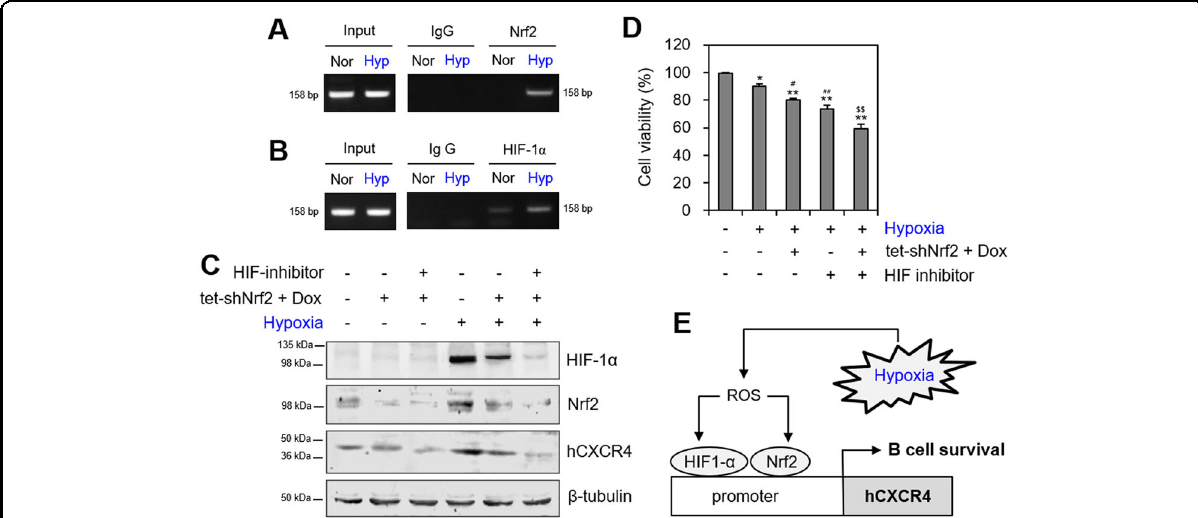
Fig. 6 B cell viability was regulated by binding Nrf2 and HIF-1 α on hCXCR4 promoter under hypoxic condition. A , B WiL2-NS cells were incubated under normoxic (Nor) or hypoxic (Hyp) condition and fi xed with 10% formaldehyde. Their chromatin extracts were immunoprecipitated with anti-Nrf2 ( A ) or anti-HIF-1 α ( B ) antibodies. DNA fragments were subjected to PCR analysis using primer sets spanning the promoter regions. Sequences for primer set were CTACATCTGATCAGTCTCCAG (forward) and AGCCCATTCAGGAGGTAA (reverse). Primer set corresponds to – 718 to – 561 bp including the second Nrf2 binding ( – 636 to – 626 bp) on hCXCR4 promoter. C , D The infected shNrf2-positive control (tet-shNrf2, − Dox) and Nrf2-KD (tet-shNrf2, + Dox) WiL2-NS cells were incubated in the presence or the absence of HIF-1 α inhibitor under hypoxic condition. Cell lysates were prepared and the protein level of each protein was measured by using western blot analysis ( C ). Cell viability was measured by using trypan blue exclusion assay. Each experiment was performed at least fi ve times. Data in a bar graph represented the means ± SD. * p < 0.05, ** p < 0.01; signi fi cantly different from control group under normoxic condition. # p < 0.05, ## p < 0.01; signi fi cantly different from shNrf2-positive control (tet- shNrf2, − Dox) with untreatment of HIF inhibitor under hypoxic condition. $$ p < 0.01; signi fi cantly different from Nrf2-KD (tet-shNrf2, + Dox) or HIF inhibitor-treated group under hypoxic condition ( D ). E This is a schematic regulatory mechanism of B cell survival by binding Nrf2 and HIF-1 α on hCXCR4 promoter under hypoxic condition. It suggests that hypoxia-induced ROS controls CXCR4 expression via the interaction of HIF-1 α and Nrf2 on its promoter